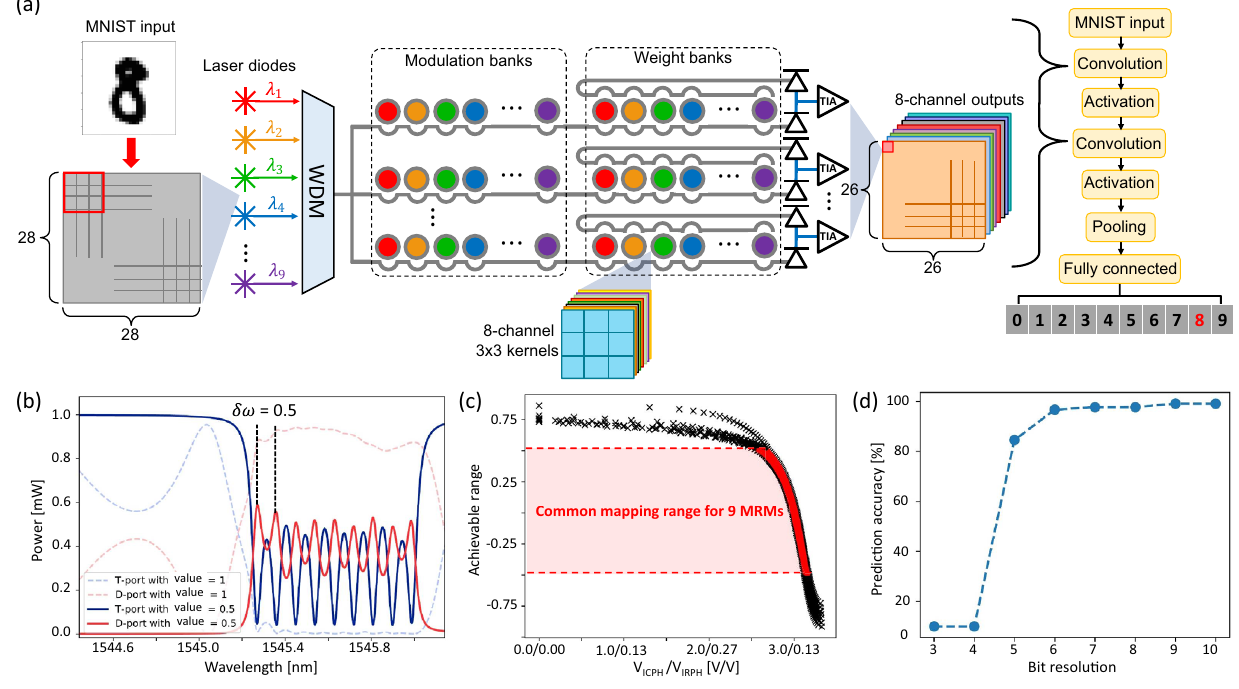
Figure 10. ( a ) Schematic of the proposed CNN architecture using IM-MRMs for modulation and weight banks. The kernel dimension is 3 3, and the number of input channels is eight. Nine lasers with different × wavelengths are used to feed the system. Input images are encoded in transmitted intensities of all-pass IM-MRMs by modulation banks. Kernel values are loaded to add-drop IM-MRMs in weight banks, which then perform the dot products with input signals. Finally, all signals are accumulated at the output port, resulting in the convolved feature. Activation functions, pooling, and fully connected layers are followed offline. ( b ) Transmission spectra of nine cascaded add-drop IM-MRMs at through (blue) and drop (red) ports with the correlated mapping value of 1 (dashed curves) and 0.5 (solid curves) in each wavelength channel. The wavelength channel spacing is limited with δω = 0.5. ( c ) Attainable mapping values for nine cascaded IM-MRMs with the limited wavelength channel spacing. A common range of [–0.5, 0.5] is used for the proposed CNN system. ( d ) Performance of the proposed CNN system on MNIST recognition task versus input